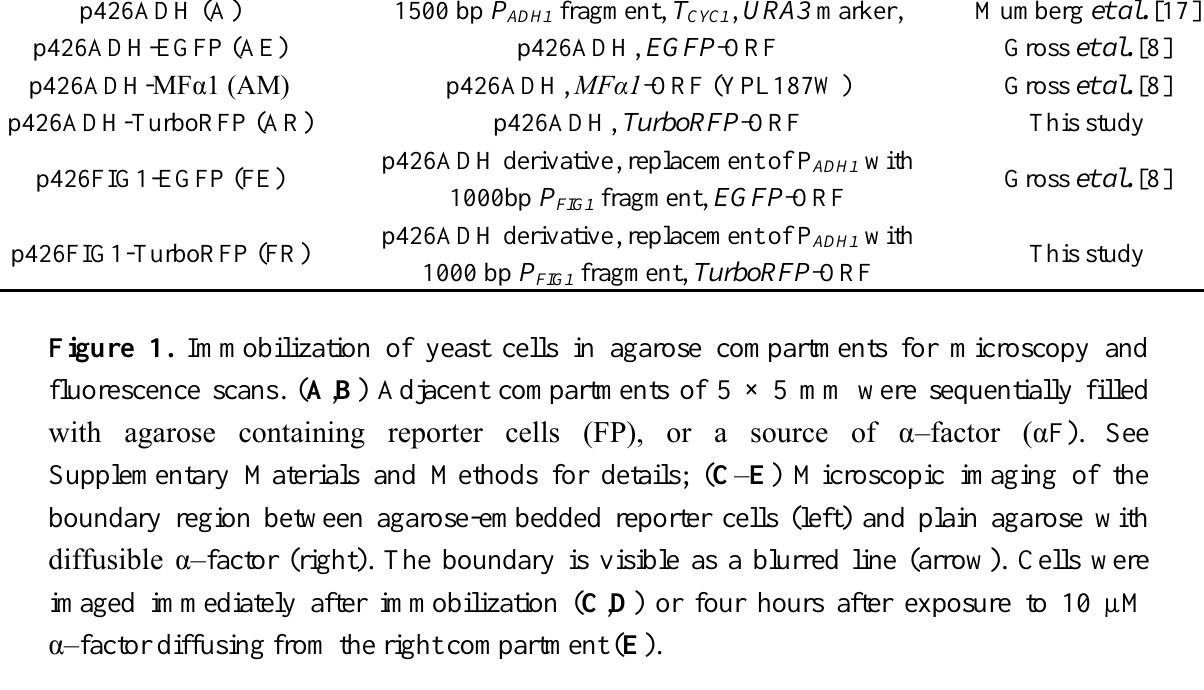
Table 1. Plasmids used in this study.